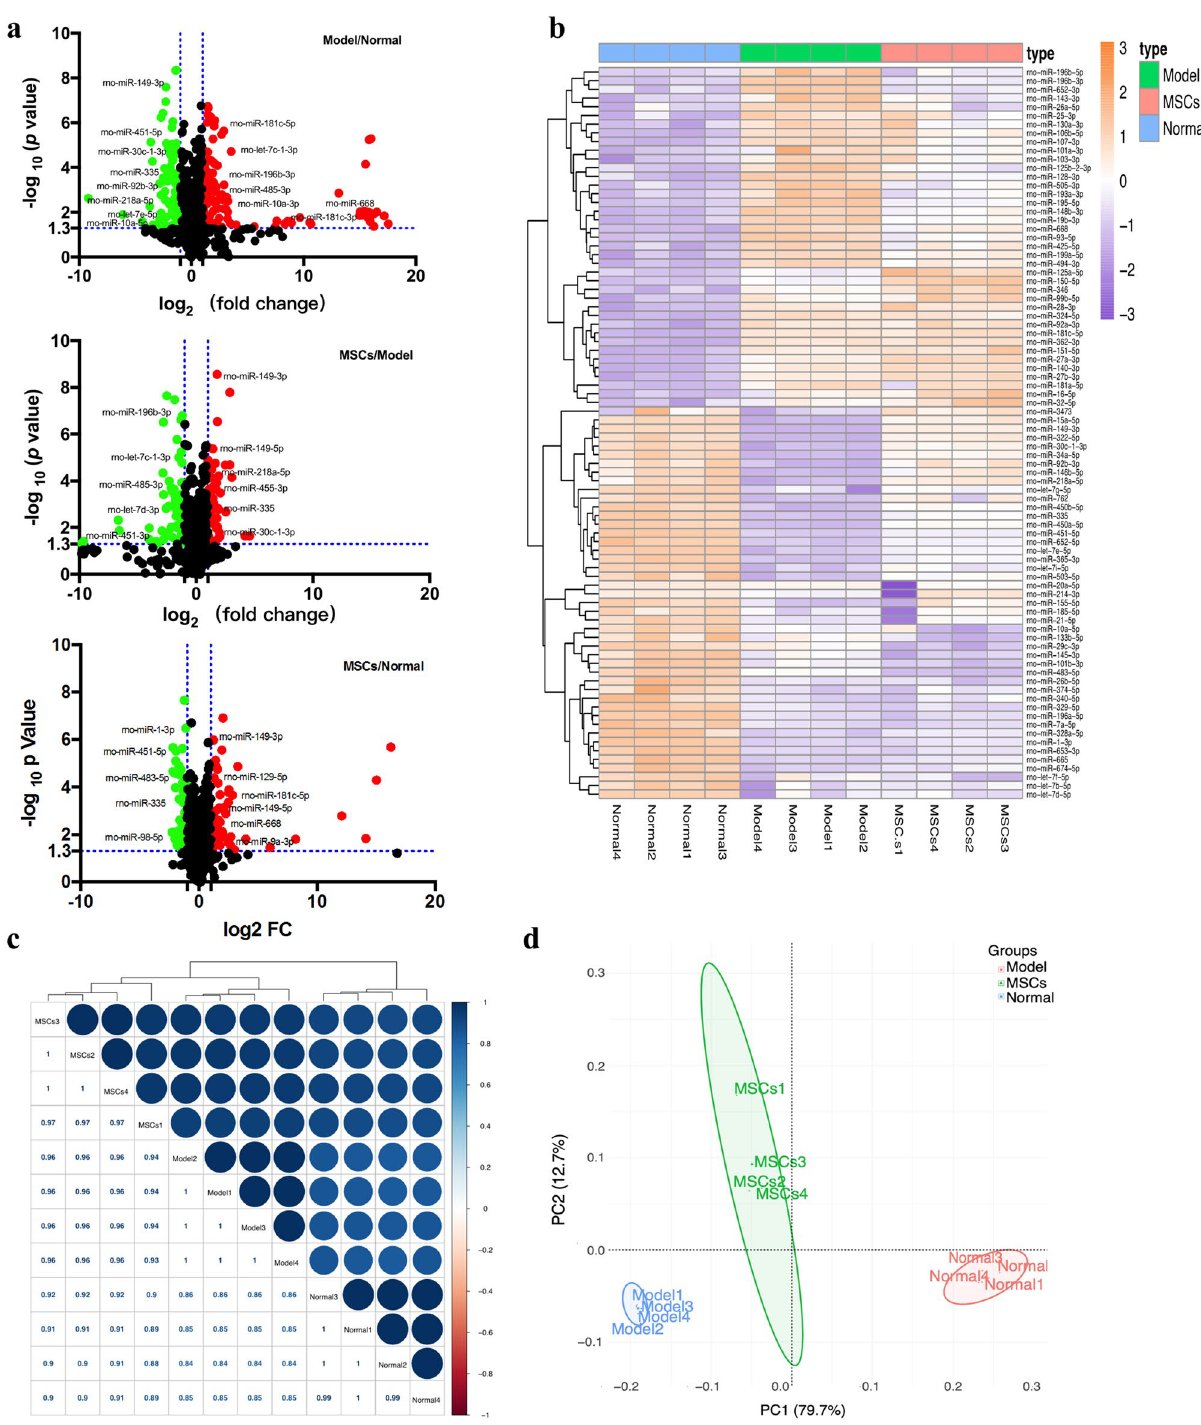
Figure 3. Analysis of miRNA prolifing. ( a ) Volcano plot displaying the differentially expressed miRNA in Model/Normal, MSCs/Model, and MSCs/Normal groups by applying a twofold change expression difference with p < 0.05. ( b ) Heatmap display of normal, model and MSCs groups enriched differentially expressed miRNAs. ( c ) Hierarchical clustering analysis of miRNAs based on the correlation matrix among the normal, model and MSCs groups. ( d ) PCA of differentially expressed miRNAs profiling data to separate the whole samples into three